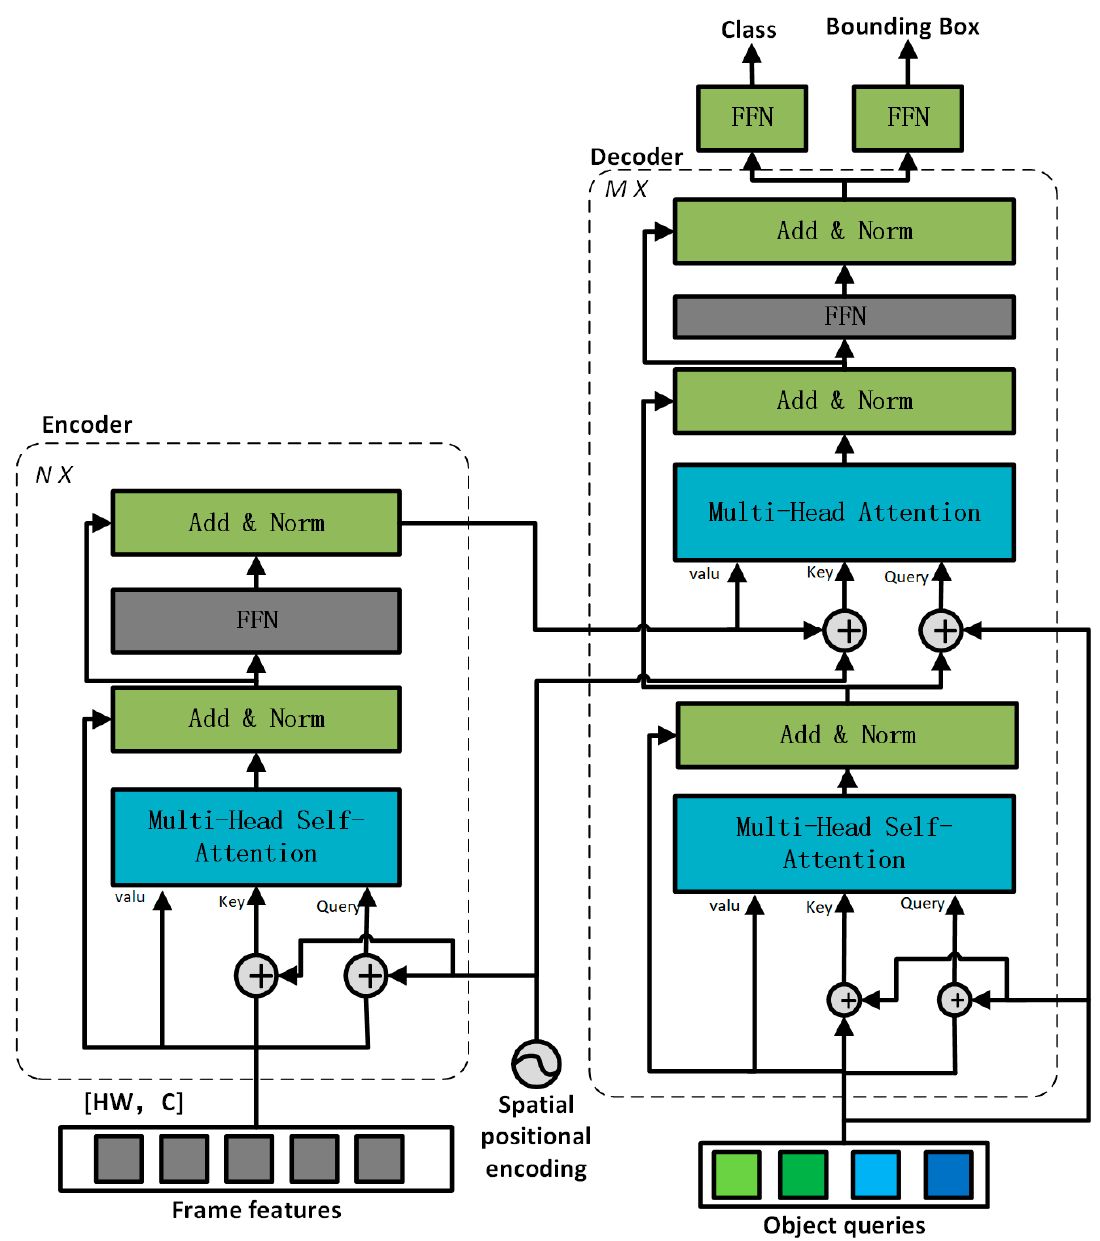
Figure 6. The transformer’s encoder–decoder architecture. (Source: Data from DETR [15] ).